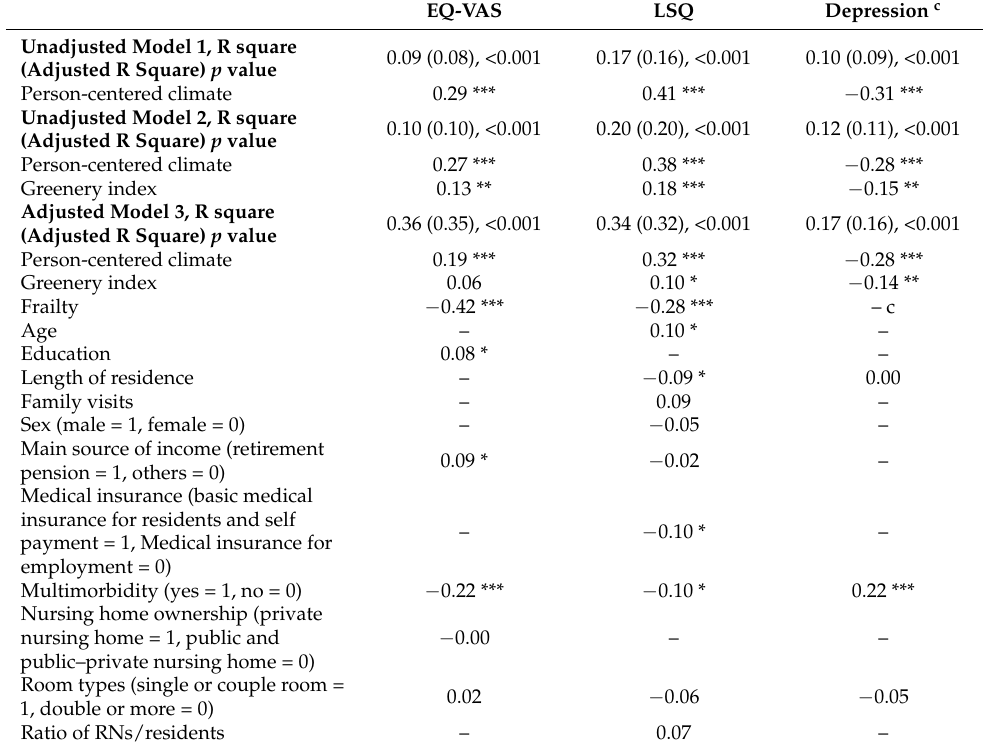
Note: Values of standardized regression coefficient. – The variable was not included in the model. a When sub-scales of Person-centered climate were entered in the regressions models, variance inflation factors (VIF) were more than 2.5, indicating multicollinearity, and therefore total score of Person-centered climate was included in the analyses. b When Having children and Ratio of total staff/residents were entered in the regression models, VIF were more than 2.5, indicting multicollinearity, therefore Having children and Ratio of total staff/residents was excluded in the analysis (leaving Family visits and Ratio of RNs/residents in the analysis). c One item of Frailty scale is the same as Depression, and therefore Frailty scale was not included in the analysis for Depression. Greenery index statistically significantly correlated with EQ-VAS, LSQ, and depression, with r s ranging from − 0.15 to 0.19. Abbreviations: EQ-VAS EuroQol-Visual Analogue Scale, LSQ life satisfaction questionnaire,